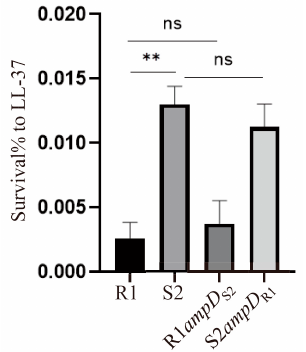
Figure 3. The susceptibility of the indicated bacterial strains to LL-37. P. aeruginosa strains were treated with 256 µg/mL LL-37 for 4 h in PBS. The viable bacterial numbers were determined by plating on an L-agar plate. The bacterial survival rate represents the ratio of recovered bacterial CFU following treatment with LL-37 to that of the initial inoculum. The data represent the means from three samples ± standard deviation. ns, not significant; **, p < 0.01, by Student’s t test.